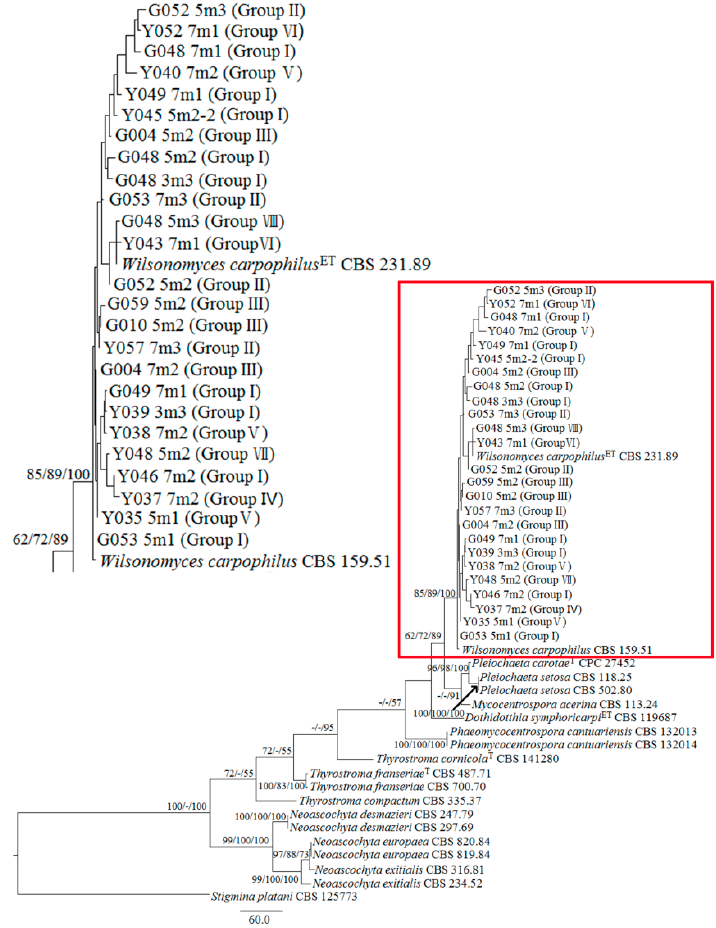
Figure 3. Phylogenetic tree showing phylogenetic relationships among species of Dothidotthiaceae inferred from a three-gene dataset comprising sequences of rDNA internal transcribed spacer (ITS) region, partial large subunit (LSU), and translation elongation factor 1-alpha (tef1) gene sequences. Backbone of the tree was constructed using Bayesian analysis. Stigmina platani was selected as an out-group. Bootstrap percentages of Bayesian posterior probabilities, maximum-likelihood, and maximum parsimony from 1000 replicates are shown, from left to right, on the deep and major resolved branches. Morphological groups in this study were labeled after isolate numbers.